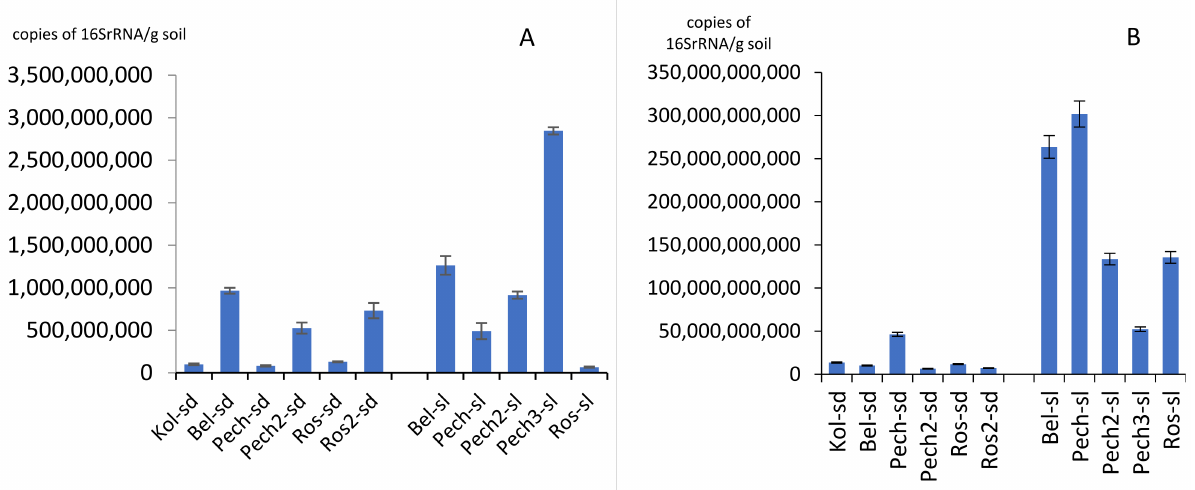
Figure 2. Number of 16S rRNA gene copies of archaea ( A ) and bacteria ( B ). The number of ITS rRNA gene copies of fungi varied from 4.28 × 10 7 /g soil in the flooded sand of Roslyakovo (sample Ros-sl) to 4.46 × 10 9 /g soil in the soil under the Pechenga grass (sample Pech-sl3) (Figure 3). Values of about 10 7 gene copies/g soil were also noted in the Kola sand (sample Kol-sd). For most samples (9 out of 11 or 81.8% of all studied samples), the number of fungi was on the order of 10 8 –10 9 gene copies/g of soil. The number of ITS rRNA gene copies of fungi, such as bacteria, in sandy soil was an order of magnitude less than in the coastal soil and varied from 4.28 × 10 7 to 4.96 × 10 8 /g soil, while in soil it varied from 1.07 × 10 9 to 4.46 × 10 9 /g soil. The largest number of fungi, as well as other groups of microorganisms, was isolated in the substrates of the Pechenga coast, the smallest—in the Roslyakovo area.